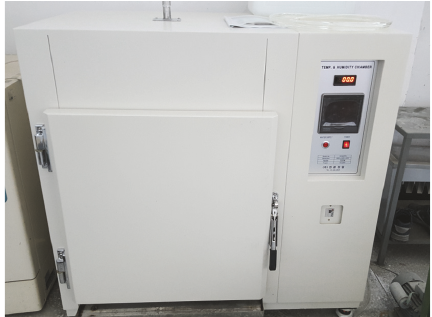
Figure 1: Autotemperature-controlled curing chamber.